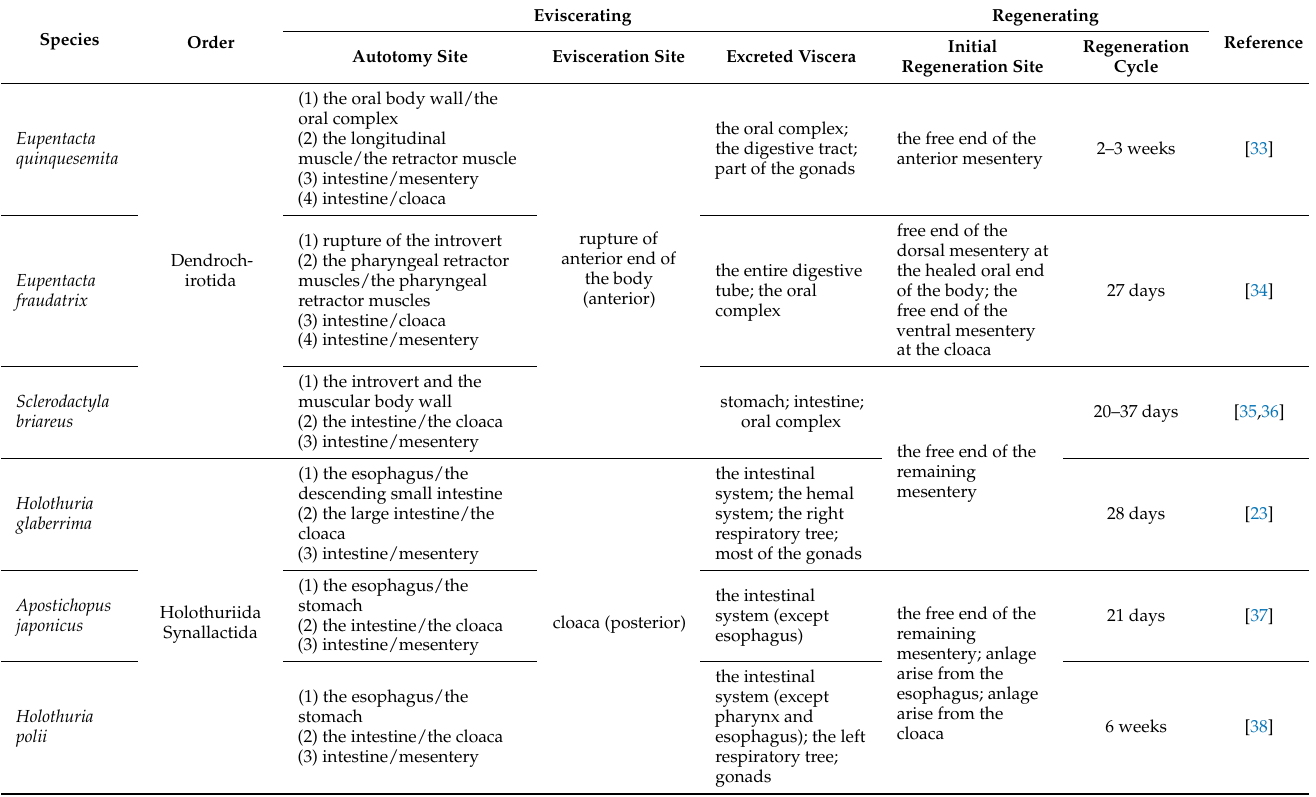
Table 1. Patterns of Evisceration and